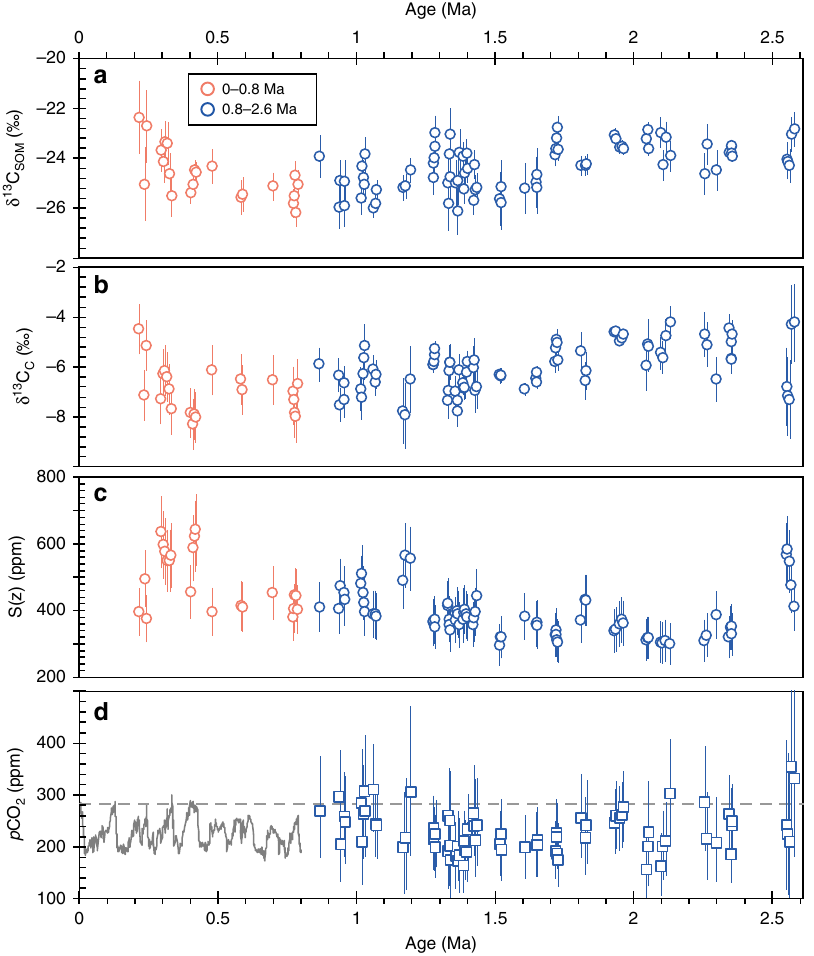
Fig. 3 Stable isotopes and calculated S ( z ) and p CO 2 . a δ 13 C values of soil organic matter ( δ 13 C SOM ). b δ 13 C values of fi nely disseminated carbonates ( δ 13 C c ). c S ( z ) estimates based on the magnetic susceptibility (MS) proxy. d Reconstructed early Pleistocene p CO 2 (median levels of p CO 2 distributions, 2.6 – 0.8Ma) and ice core CO 2 record (0.8 – 0Ma) 36 . Horizontal gray line shows the pre-industrial p CO 2 level (280ppm). Errors associated with δ 13 C c and δ 13 C SOM are standard deviations of all measurements within the same paleosol unit ( n >3). Error bars related to p CO 2 represent the 16th and 84th percentiles (1 σ ) based on PBUQ Monte Carlo simulations 7 , whereas errors associated with S ( z ) were calculated based on Gaussian error propagations (Supplementary Note